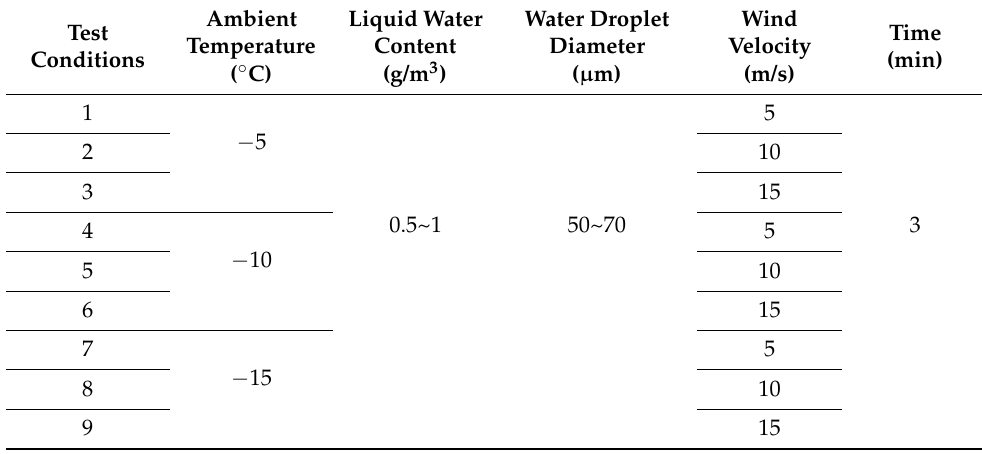
Table 2. Icing wind tunnel test